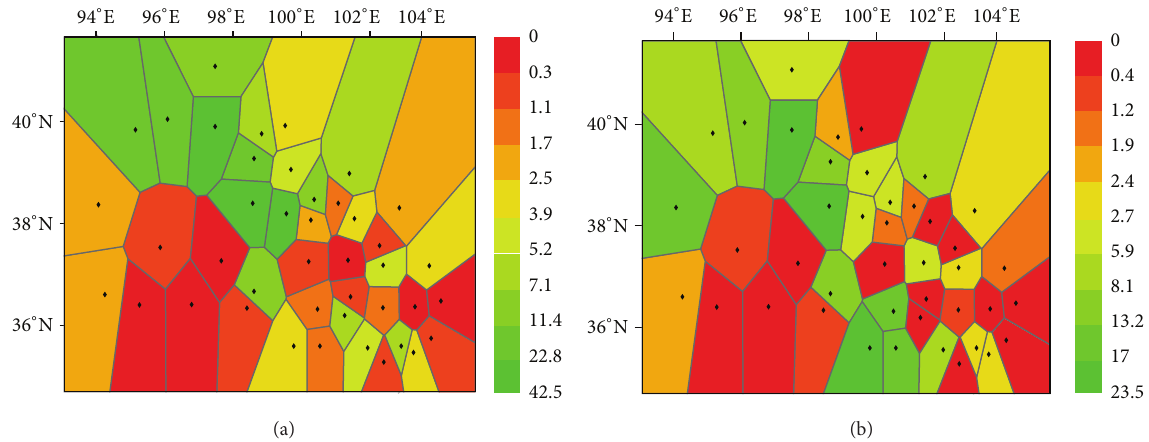
Figure 3: Spatial distribution of the rainfall accumulation for the durations of the two events shown in Thiessen polygons: (a) Event A; (b) Event